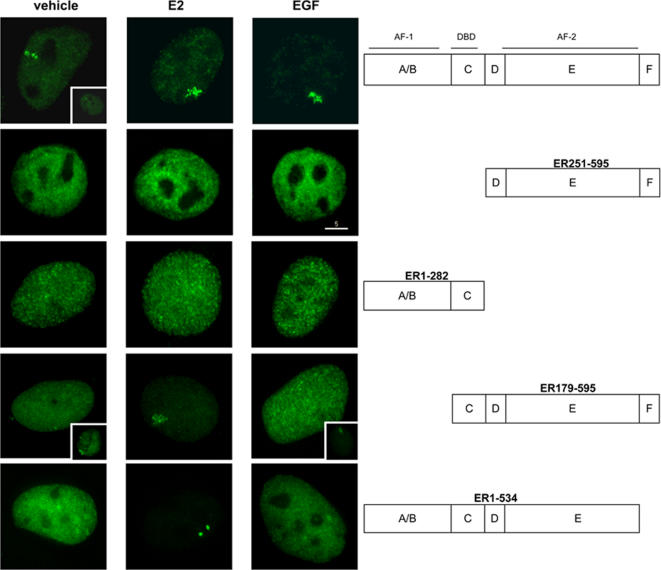
Role of AF-1 and AF-2 ER domains in promoter binding.Representative images of PRL-HeLa cells transiently expressing the indicated deletion mutants and treated with either ethanolic vehicle, E2 or EGF for 2 hours (see Table 1). The inset images are representative of fluorescence images observed in a minority of cells. The size bar is in microns. All images were captured so as to optimize the intensity of the GFP-ER.